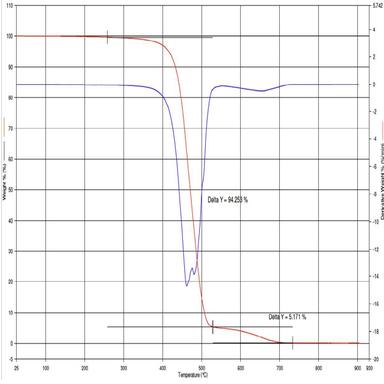
TGA thermogram for neat ABS showing zero residual weight.